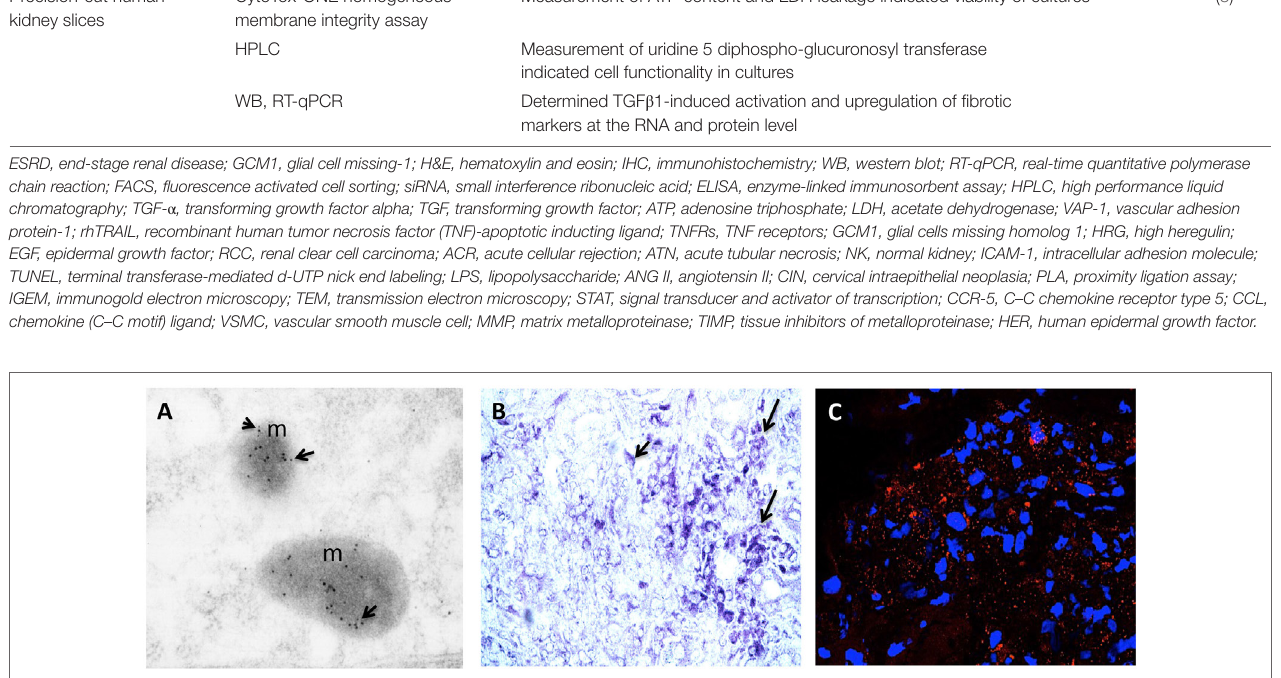
FiGURe 2 | (A) RCC organ cultures treated with recombinant human TNF for 3 h and subjected to immunogold electron microscopy. Colloidal gold particles representing localization of phospho-MLKL (Ser358) (5 nm) and phospho-dyamin-related protein-1 (Drp1) (Ser616) (10 nm) and are detected in mitochondria (m). Mag: 105k × . (B) Representative light micrograph of RCC organ cultures treated with recombinant human TNF for 3 h were subjected to in situ hybridization using anti-sense probe to RIPK3 conjugated with Digoxigenin (DIG). Intense blue staining using anti-DIG-alkaline phosphatase and BCIP/NBT substrate (blue color) is seen in sites of gene expression within the cytoplasm of tumor cells. Original mag: 63 × . (C) Representative confocal image of RCC organ cultures treated with recombinant human TNF for 3 h and subjected to in situ proximity assay to determine interaction between RIPK3 and phosphorylated-MLKL (Ser358). Numerous strong red fluorescent spots are evident within the cytoplasm of malignant TECs (mTECs) indicating close proximity of RIP3/pMLKL ( < 40 nm). Original mag: 63 × . TNF, tumor necrosis